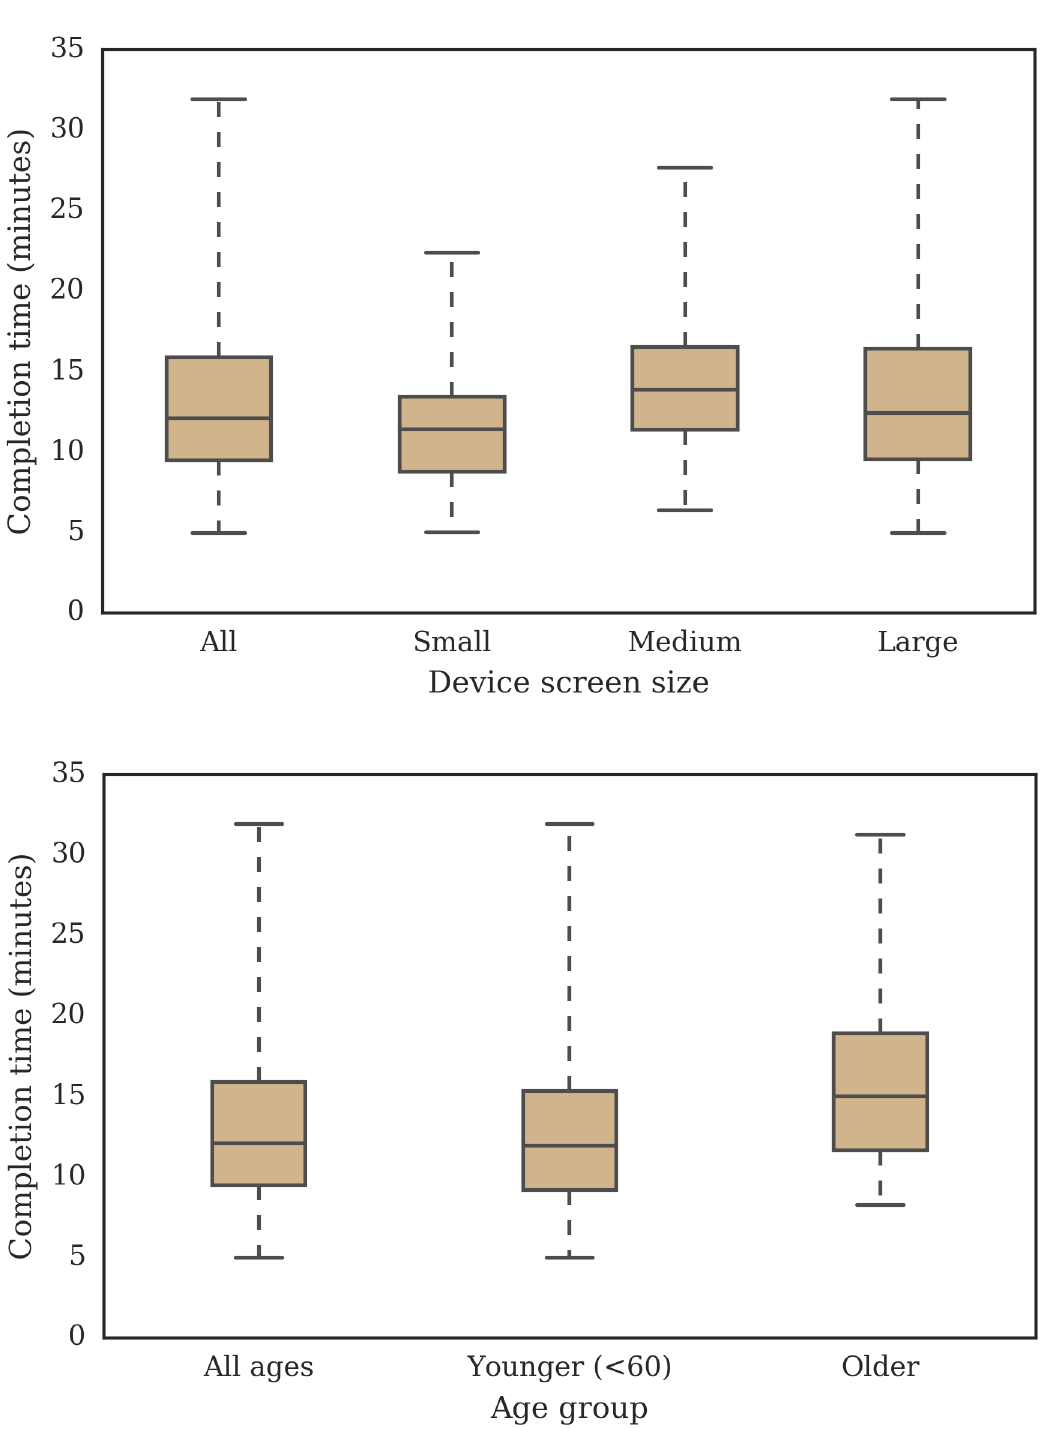
Fig 3. FFQ completion time for participants (n = 324) during the EatWellUK study presented by small (n = 92), medium (n = 38) and large (n = 191) device screen sizes and by younger (n = 271 < 60 years) and older (n = 53) adults. The device screen sizes were classified as small (less than 480 pixels), medium (between 480 and 1240 pixels, inclusive) and large (more than 1240 pixels).